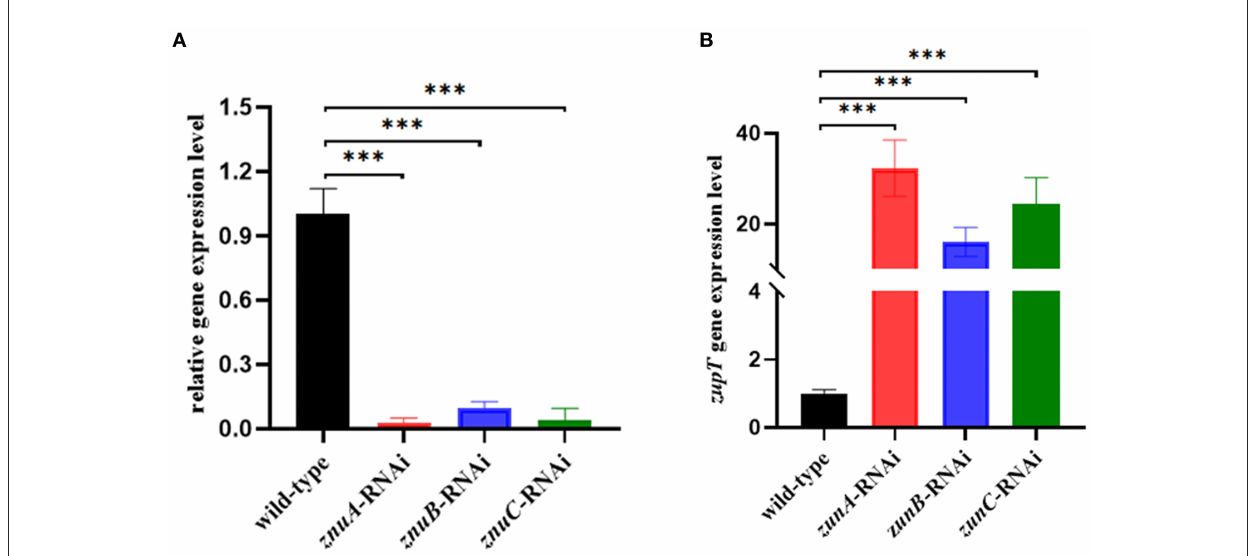
FIGURE1 Construction of A. salmonicida SRW-OG1 znuA , znuB , and znuC silencing strains and expression of zupT in wild-type and the silencing strains. (A) was qRT-RCR validation of silencing efficiency of znuA -RNAi, znuB -RNAi, and znuC -RNAi. (B) was the expression levels of zupT in wild-type, znuA , znuB , znuC -RNAi strains of A. salmonicida SRW-OG1; Data were presented as mean ± standard deviation (SD) ( n = 3). *** P < 0.001.